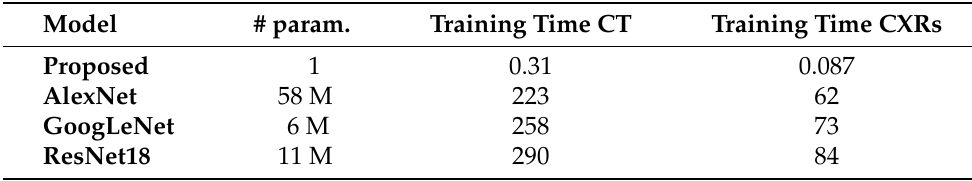
Table 10. Computational complexity of the tested models (“M” stands for millions of parameters). The training time, in minutes, refers to data sets composed of images of size 300 × 200 pixels for the CT dataset and 320 × 390 pixels for the CXR dataset. The number of images is presented in Table 2. Model #